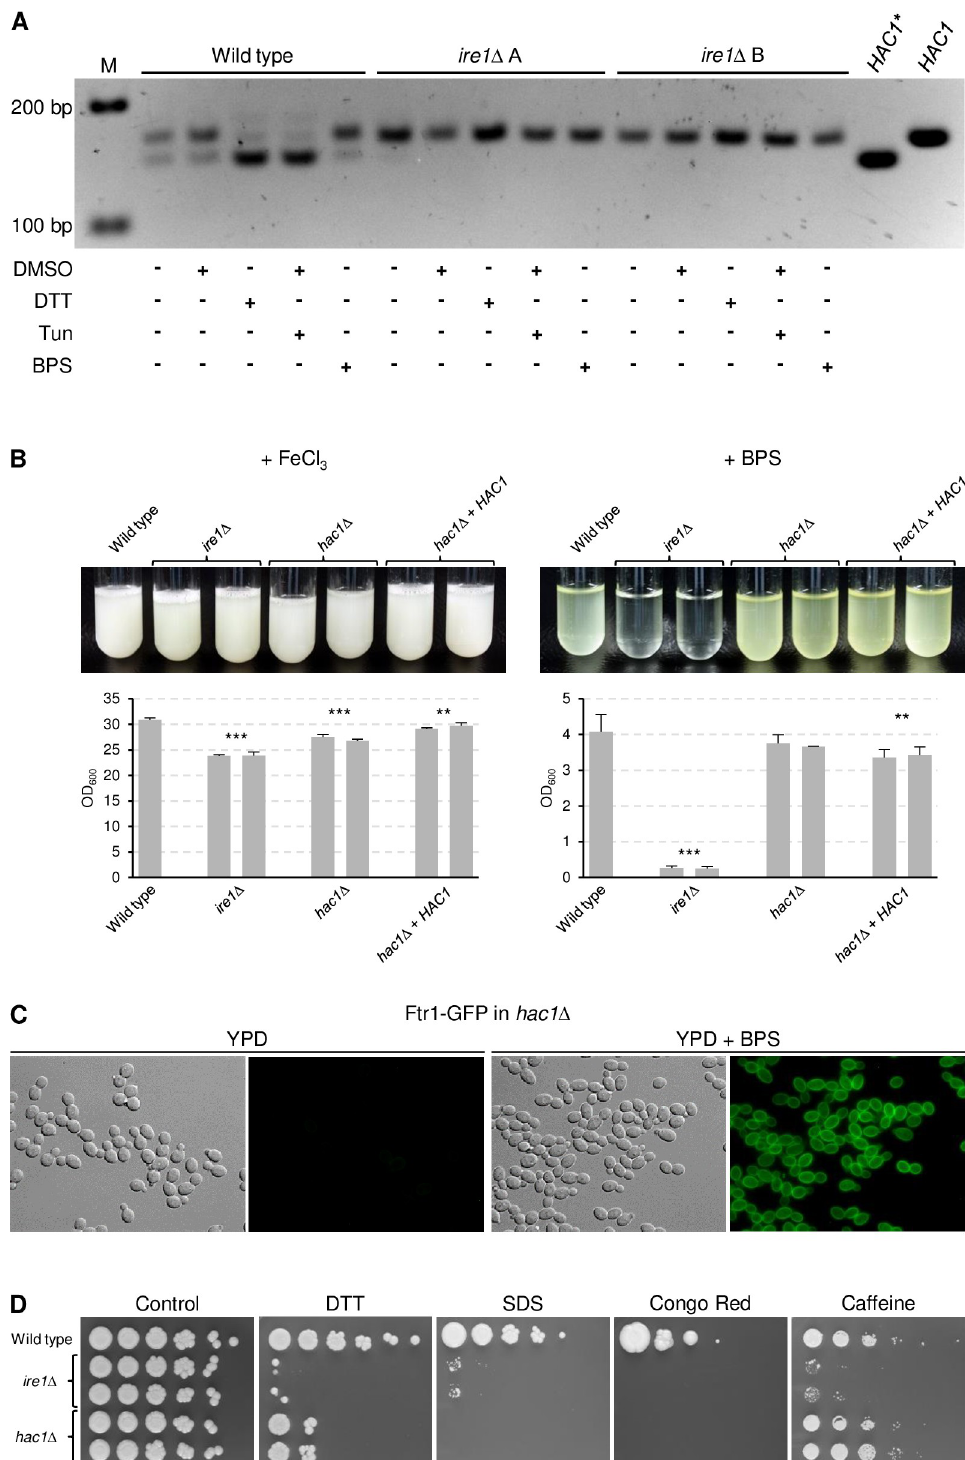
Fig 10. HAC1 is not required for growth of C . albicans under iron-limiting conditions. (A) Detection of spliced and unspliced forms of HAC1 mRNA in the wild-type strain SC5314 and ire1 Δ mutants. The strains were grown in